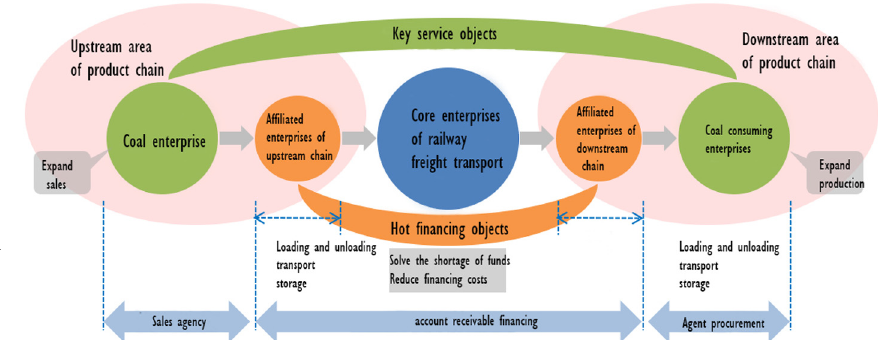
Figure 1. Chain diagram of supply chain fi nancial